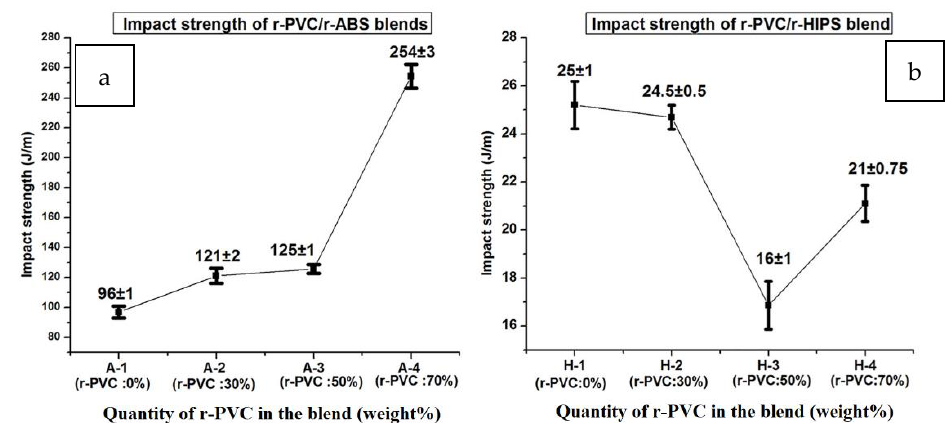
Figure 36. Impact strength of recycled PVC blended with ( a ) recycled ABS blends and ( b ) recycled HIPS. Reprinted with permission from ref. [102].